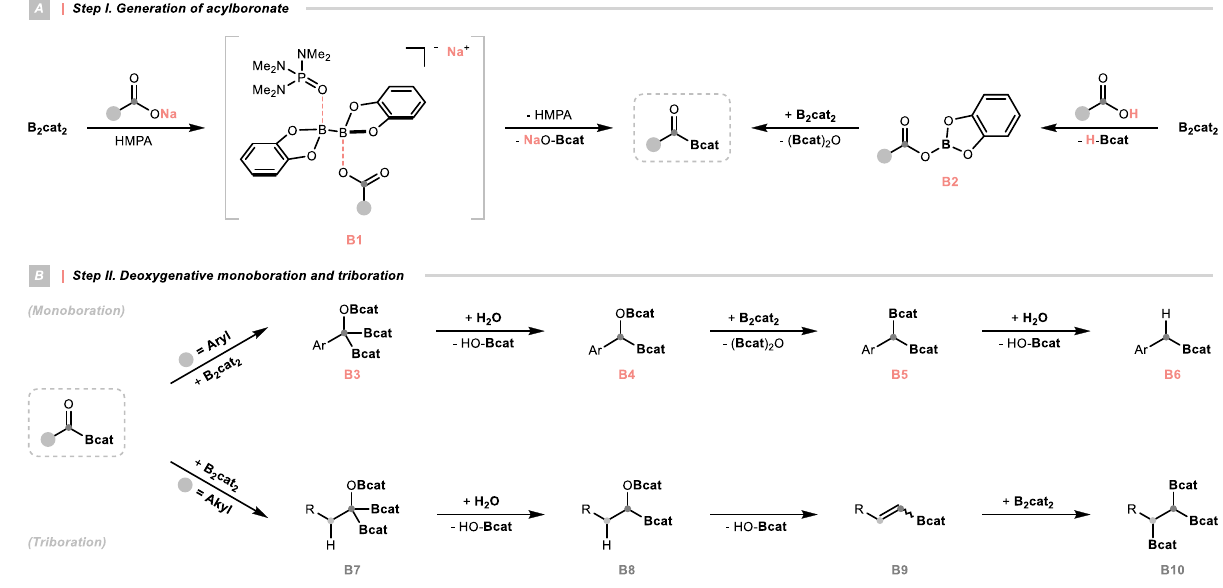
Fig. 5 Proposed mechanism. A Step I. Generation of acylboronate; B Step II. Deoxygenative monoboration and triboration. B 2 cat 2 bis(catecholato)diboron, Bcat boronic acid catechol